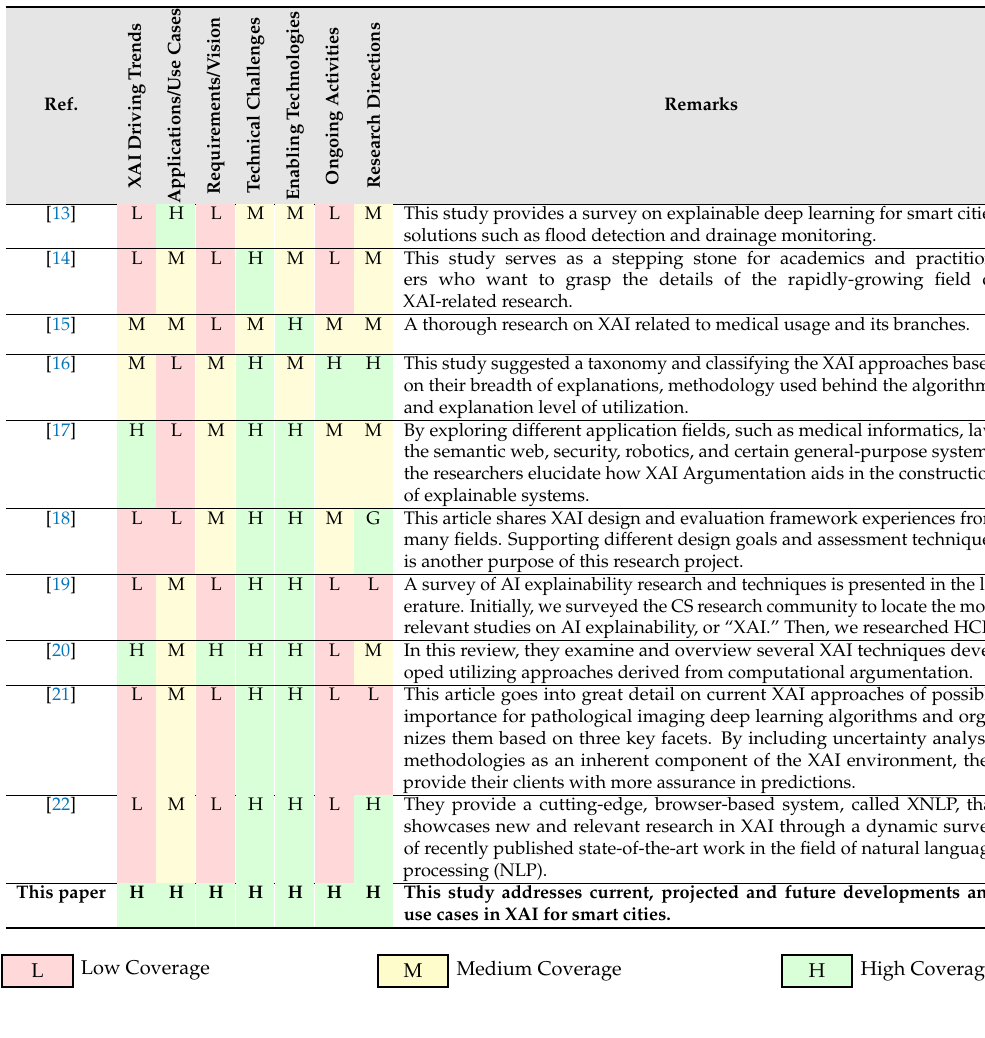
Table 1. Summary of important surveys on